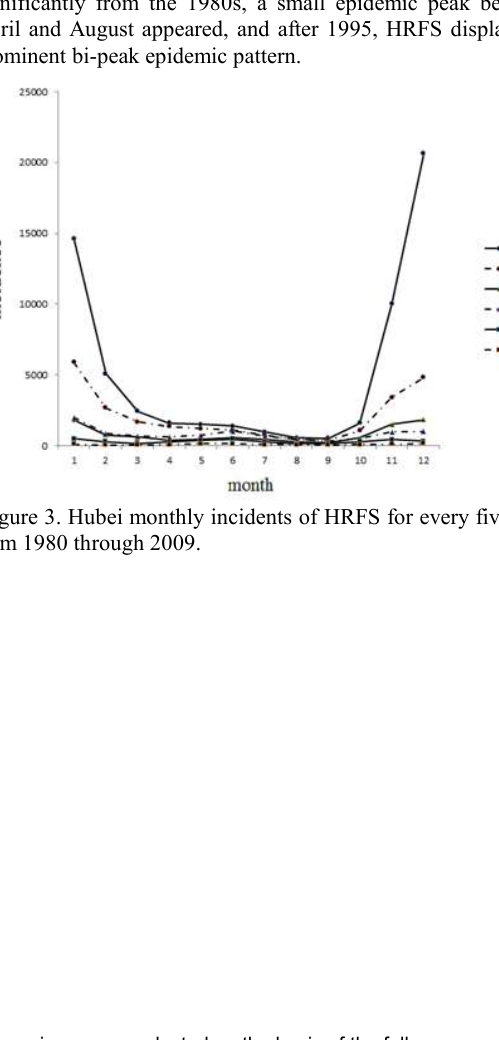
Figure 2. HFRS incidence and fatality trends for each year from 1980 through 2009.